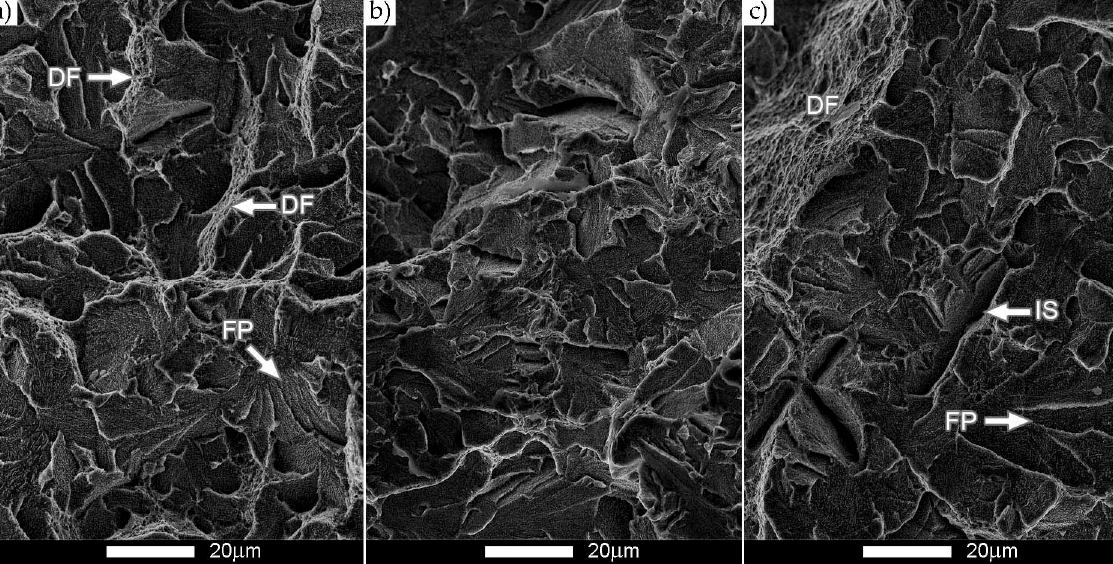
Figure 17. Images of the Hardox Extreme steel fracture surface in normalized state shown in Figure 10: transverse orientation (+20 °C). ( a ) The area marked with the A1 frame. ( b ) The area marked with the B1 frame. ( c ) The area marked with the C1 frame. DF—ductile fracture, FP—fan pattern, IS—intergranular steps. SEM, non-etched state.